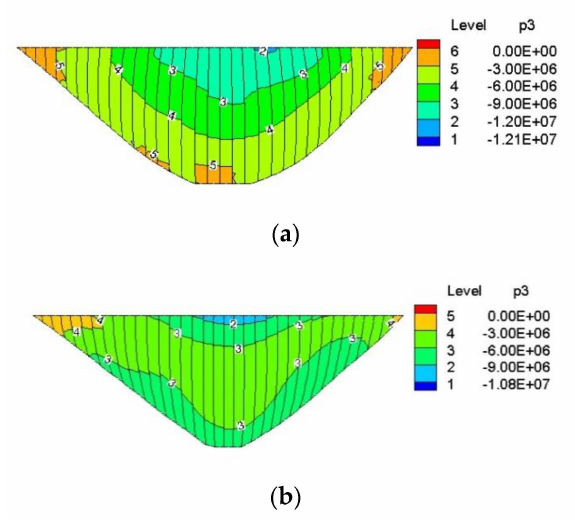
Figure 7. Envelopes of maximum compressive principal stresses using the old standard (Pa). ( a ) Up- stream surface and ( b ) downstream surface.